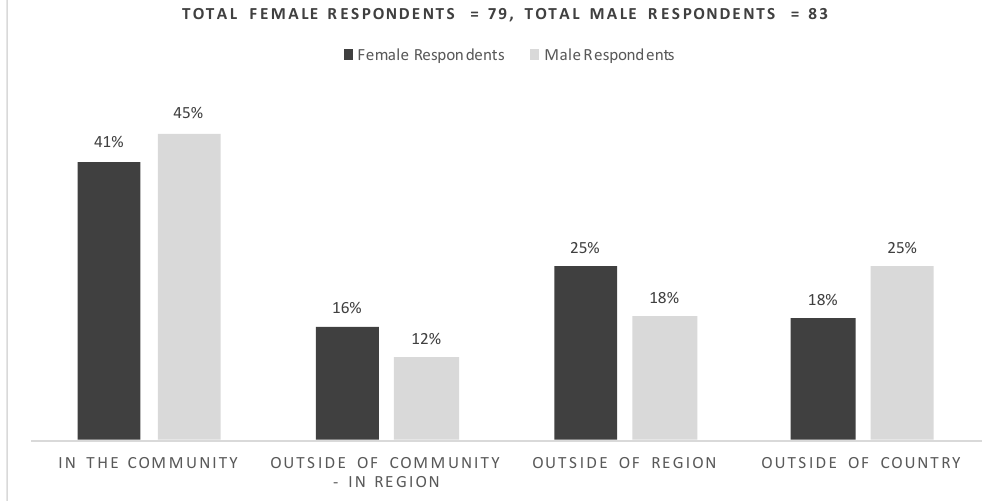
Figure 6. Where youth hope to be living when 30 years old.